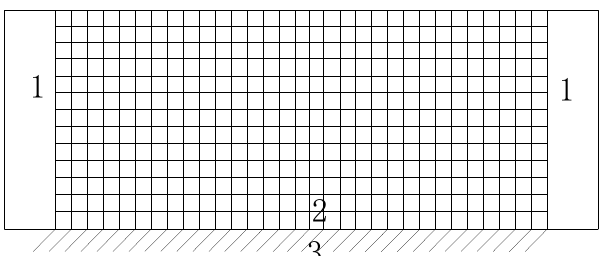
Figure 6. A numerical model of free field vibration.